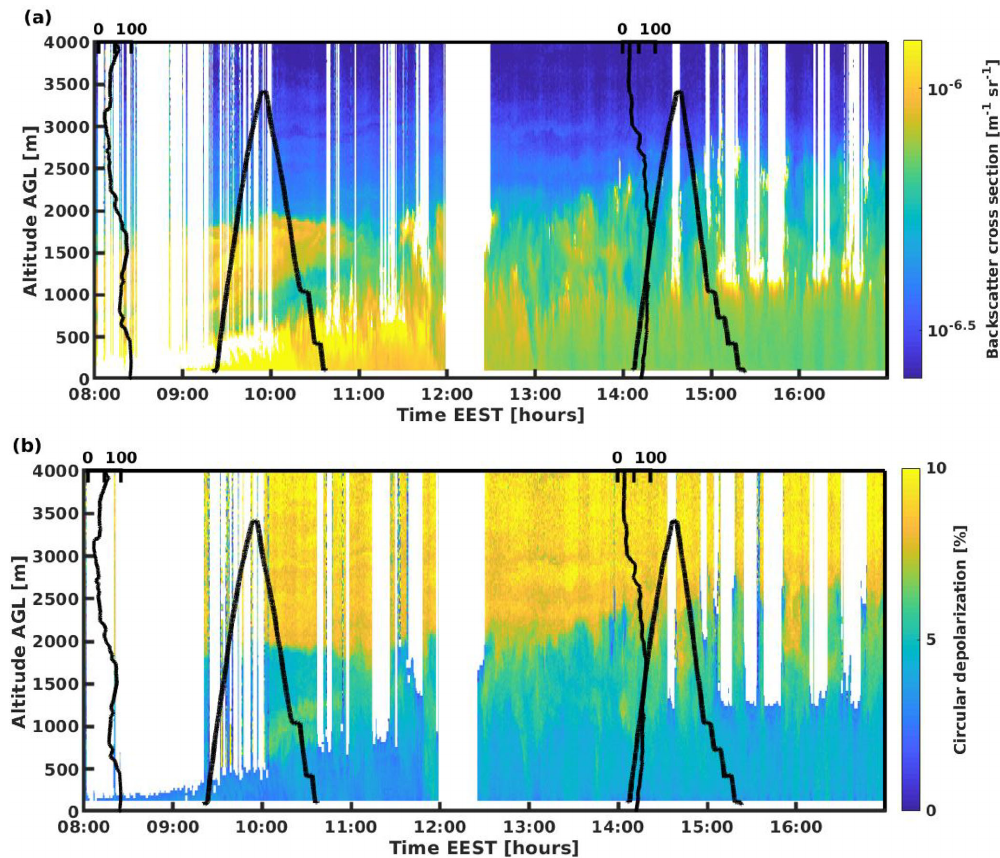
Figure 6. Case II: (a) HSRL backscatter coefficient and (b) HSRL circular depolarisation over Hyytiälä, Finland on 22 August 2014, with 6-hourly radiosonde relative humidity profiles, and the two Cessna flight altitude tracks superimposed in black. White pixels indicate no valid measurement due to the presence of cloud and subsequent attenuation above or maintenance